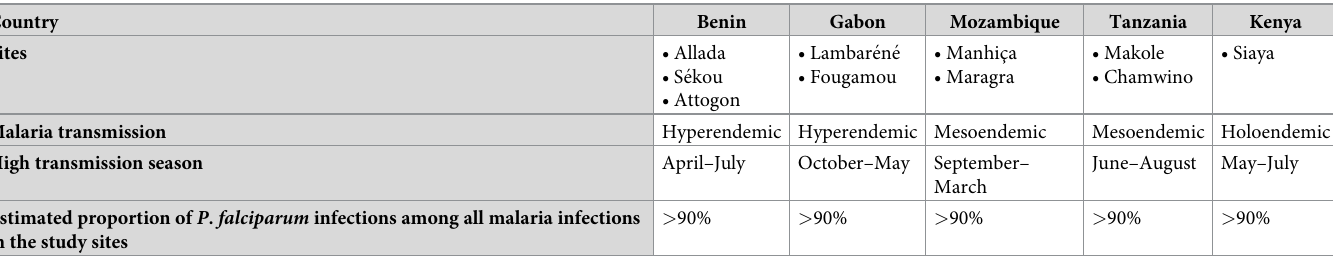
Table 1. Characteristics of study sites.